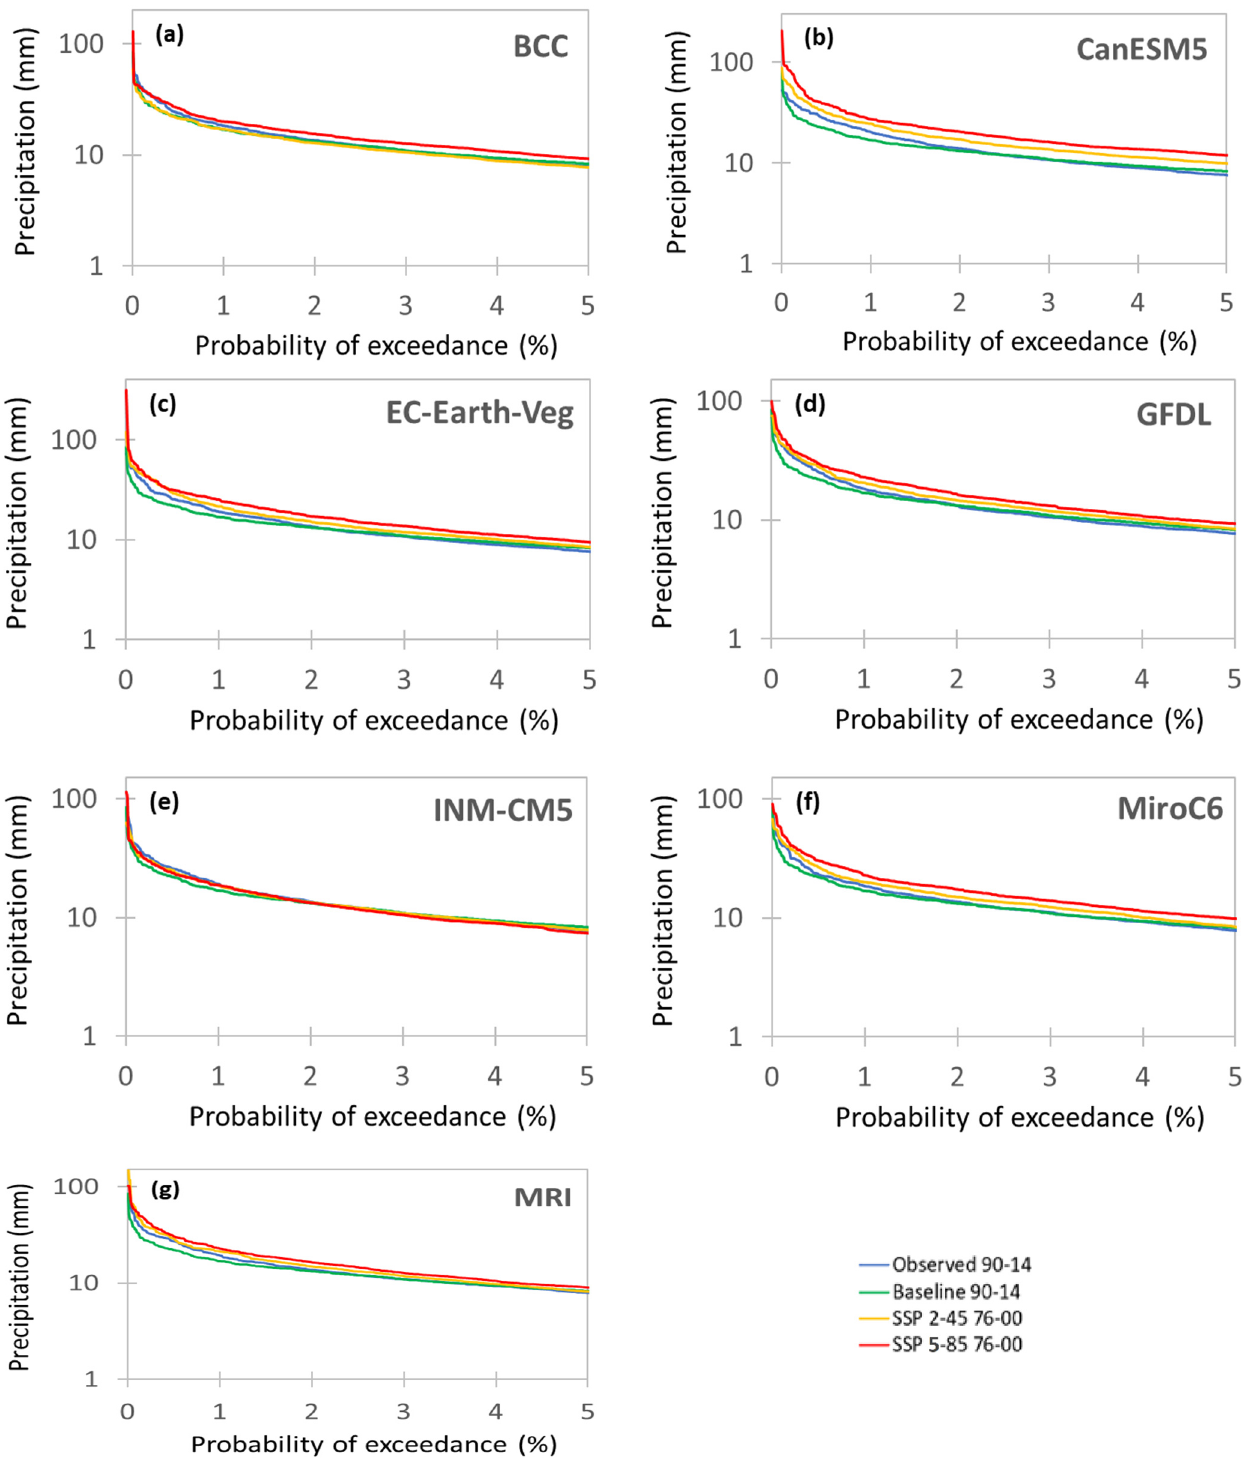
Figure 6. Exceedance probability distribution of daily precipitation for observed, baseline and projected data. Each subfigure represents a different GCMs: ( a ) BCC, ( b ) CanESM5, ( c ) EC-Earth-Veg, ( d ) GFDL, ( e ) INM-CM5, ( f ) MiroC6, ( g ) MRI.